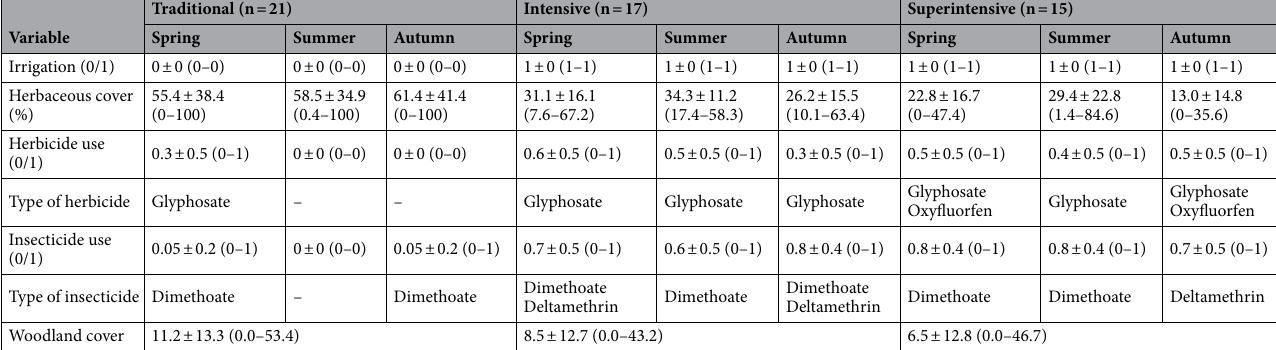
Table 2. Summary statistics (mean ± SD; min.-max.) of the variables used to characterise the management and landscape context of orchards in each intensification level in each season. The herbicides and insecticides most frequently used are also